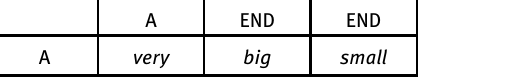
Table 1: Finite state automaton in table notation as procedural model for grammar